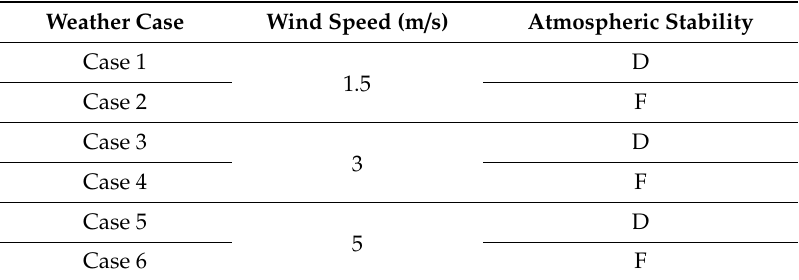
Table 4. Simulation results at ambient temperature (25 °C).